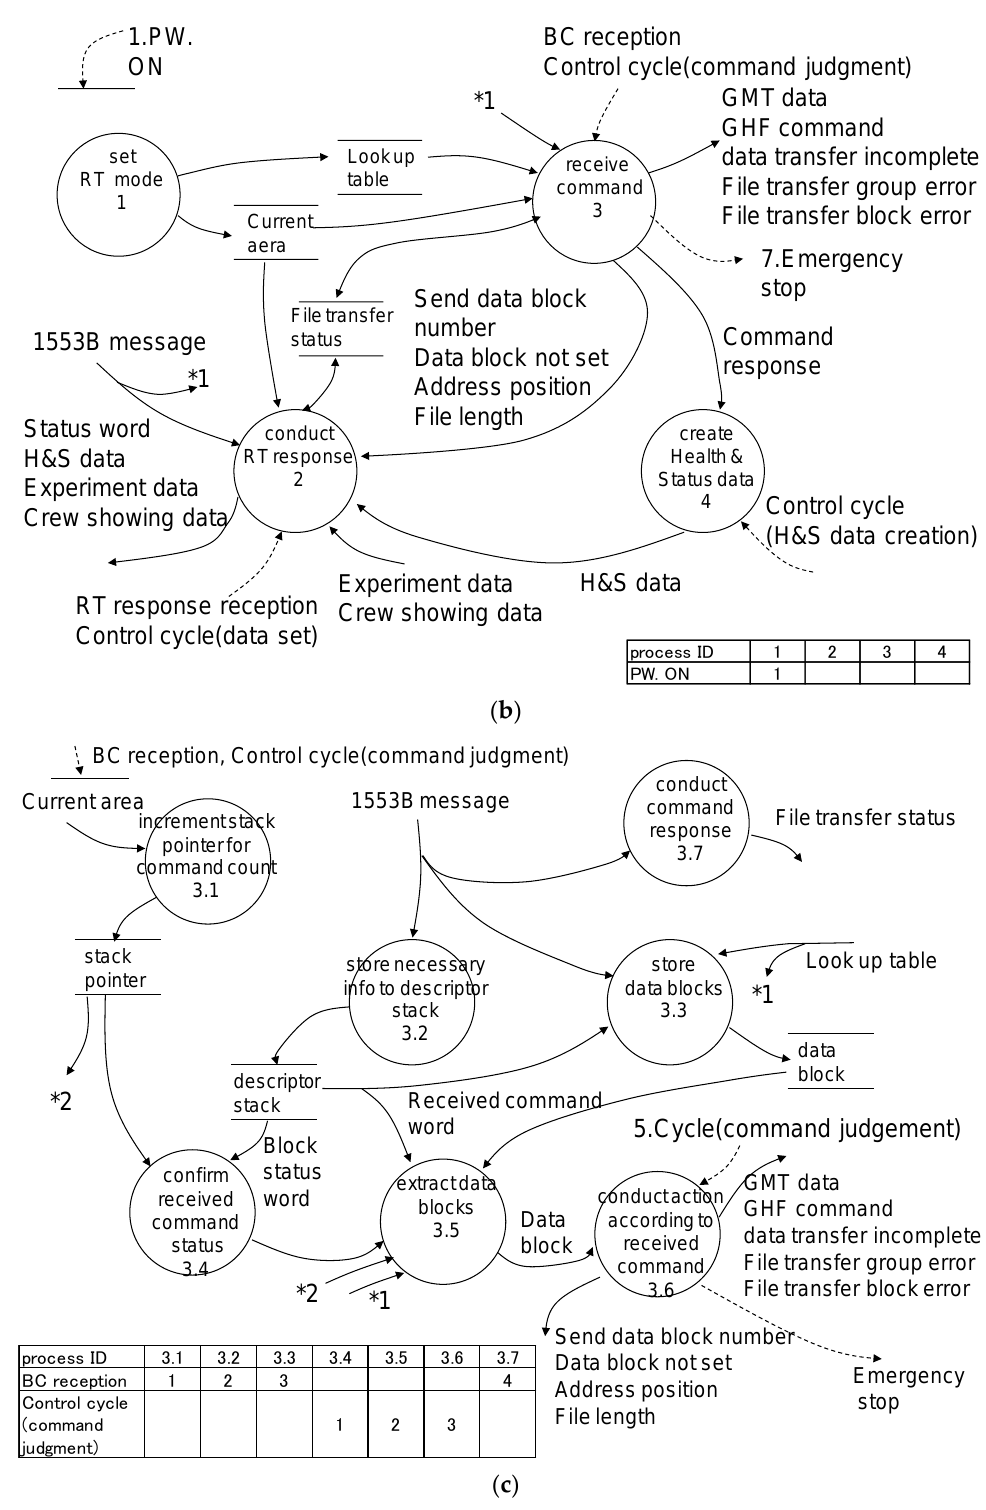
Figure 10. ( a ) Design Result of Communication CSW – Data Context Diagram (DCD) and Control Context Diagram (CCD). ( b ) Design Result of Communication CSW – Data Flow Diagram (DFD), Control Flow Diagram (CFD), and Control Specifications (CSPEC) in the Second Layer. ( c ) Design Result of Communication CSW – DFD, CFD, and CSPEC of Process 3.